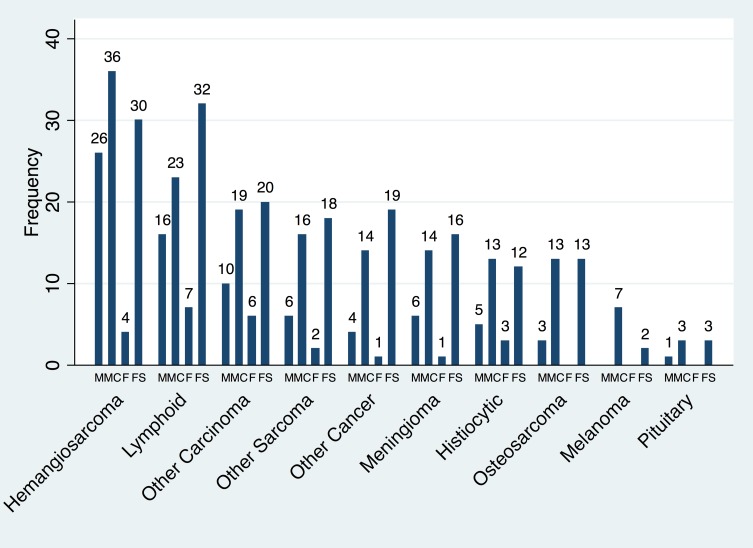
Histologic types of cancer diagnosed by sex.Bar graph showing frequency of tumor type leading to death in golden retriever dogs categorized by sex and spay or neuter status. M = intact male, MC = castrated male, F = Intact female, FS = spayed female.